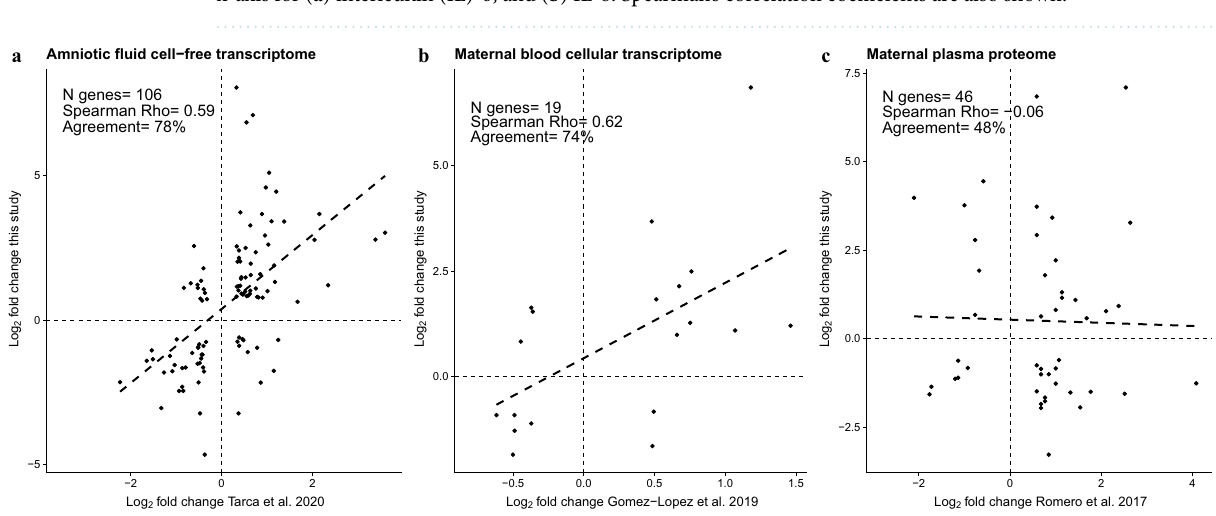
N genes= 106 Spearman Rho= 0.59 Agreement= 78%